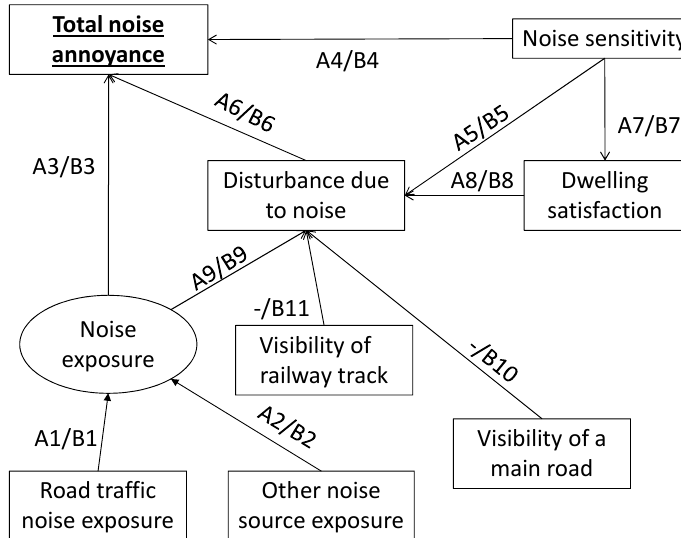
Figure 2. Psychophysical structural equation model of total noise annoyance without and with Visibility of noise source. A1 to A9 represent the standardized coefficients in Model psy-A, whereas B1 to B11 represent the standardized coefficients in Model psy-B. The variable Combined noise exposure is represented in an oval as it is a latent variable influenced by the Noise exposure manifest variables.